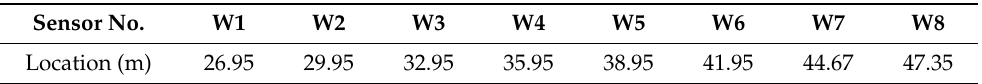
Table 1. Location of the wave profile sensors (distance to the wave maker).